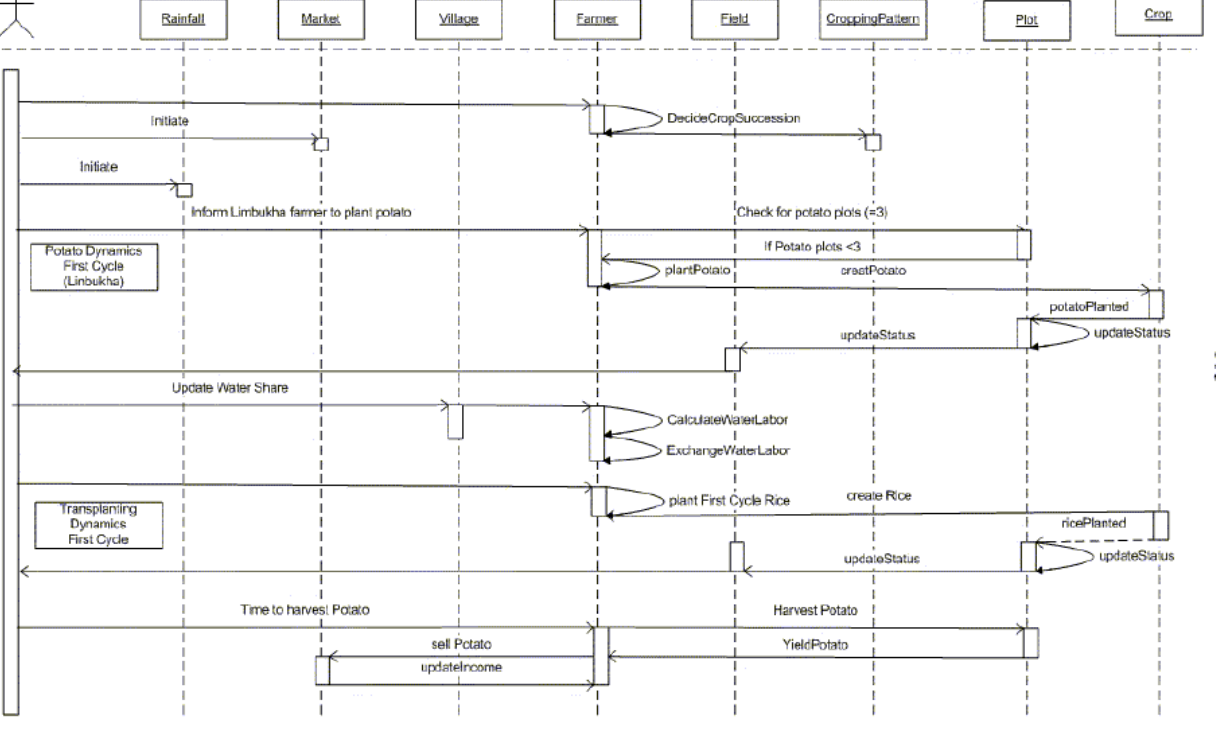
Fig. A2.7. Sequence diagram of the Limbukha model (Cycle 2 corresponds to mid-June to